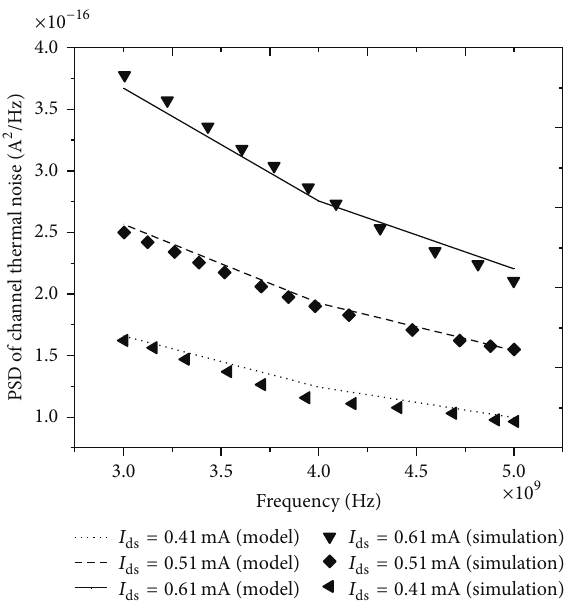
Figure 4: Power spectral density of channel thermal noise versus thermal resistance of the